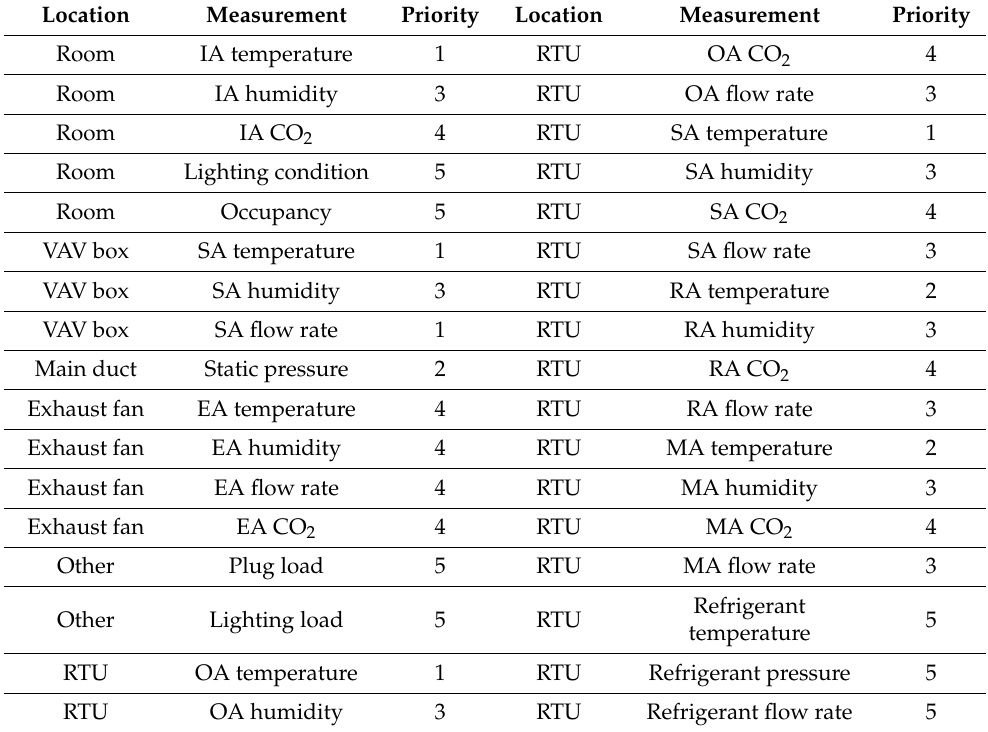
Table 1. Comprehensive sensor list.